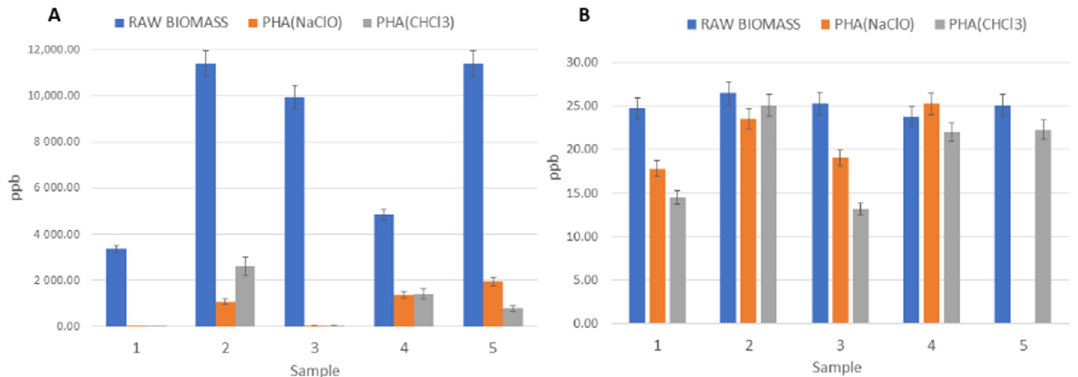
Figure 1. ( A ) Fluoranthene concentration in thermal-stabilized PHA-rich biomass from Treviso facility determined on 5 samples of raw biomass and after chloroform and hypochlorite extraction; ( B ) benz(a)anthracene concentration in thermal- stabilized PHA-rich biomass from Treviso facility determined on 5 samples of raw biomass and after chloroform and hypochlorite extraction.